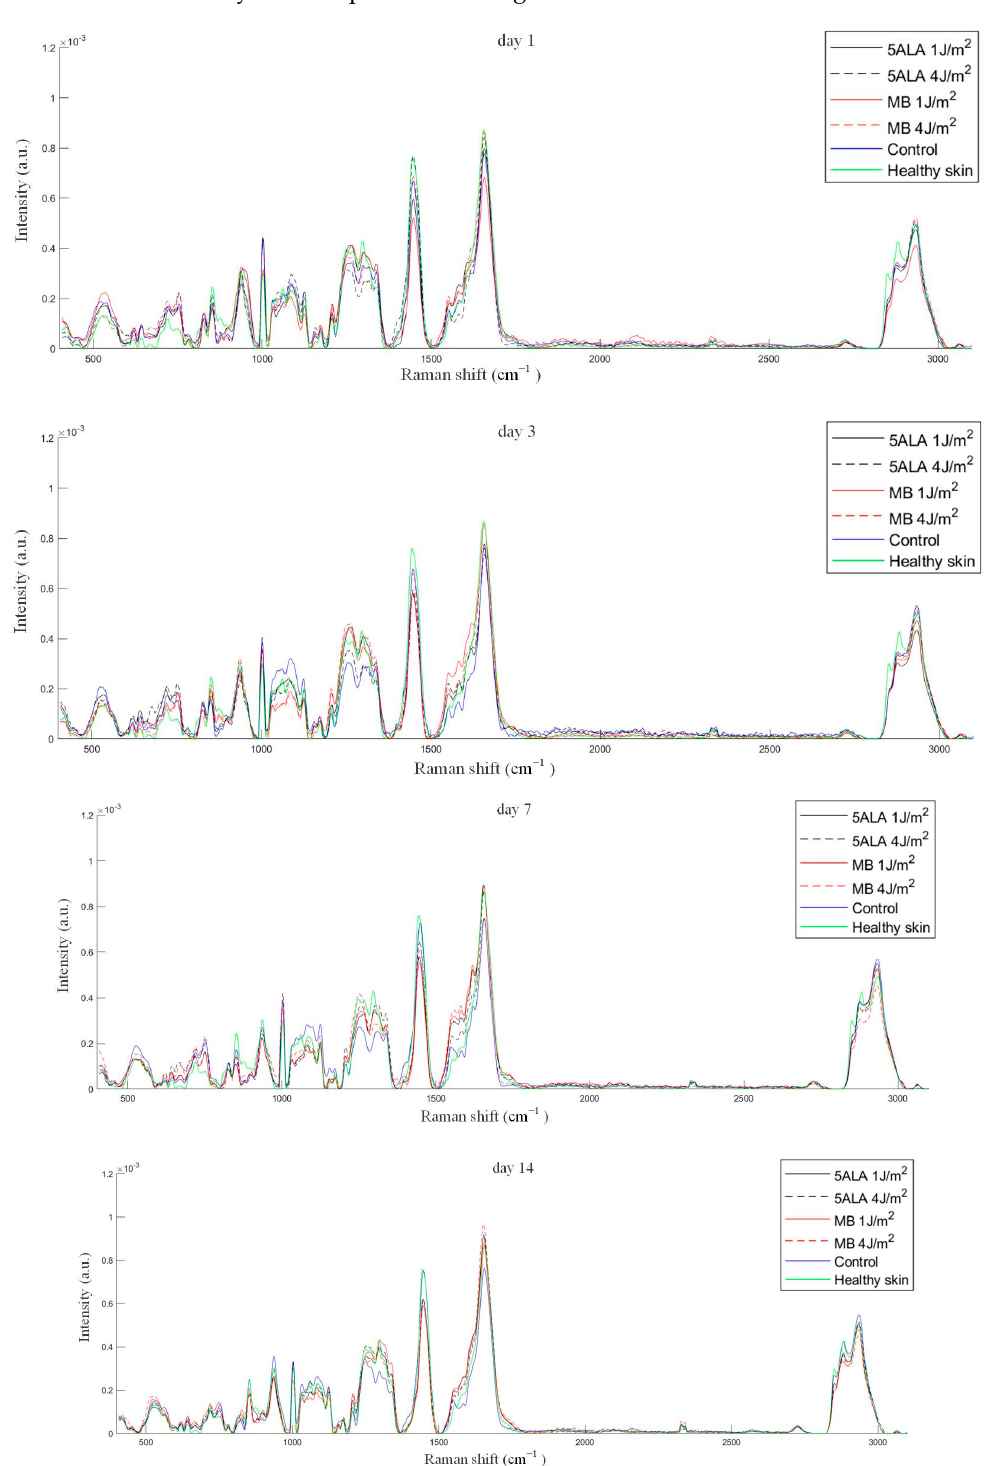
Figure 9. The mean Raman spectra of skin wounds in all groups on all observation days and healthy skin, black line—5ALA 1 J/cm 2 , black dashed line—5ALA 4 J/cm 2 , red line—MB 1 J/cm 2 , red dashed line—MB 4 J/cm 2 , blue line—control, green line—healthy skin (the number of processed Raman spectra was equal to 30 for each group).